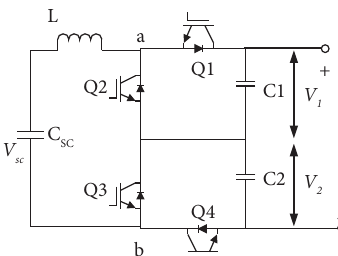
Figure 5: Te confguration of the three-level buck-boost converter.